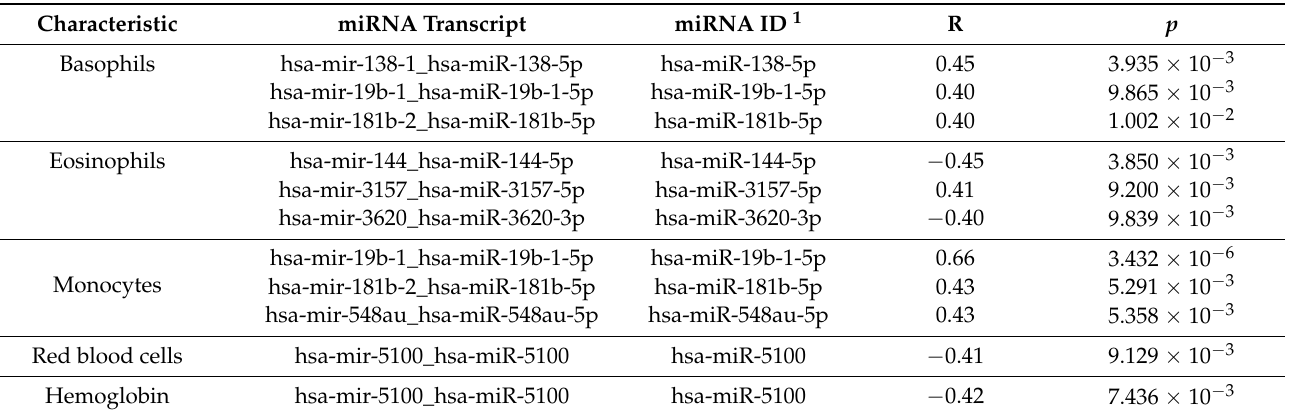
Table 4. Results of the correlation analysis performed between 24 miRNAs selected as potentially associated with LEAD indicators and continuous characteristics of the study group. The table presents the correlations obtained with the absolute value of the Spearman correlation coefficient ≥ 0.4 and p value < 0.05.